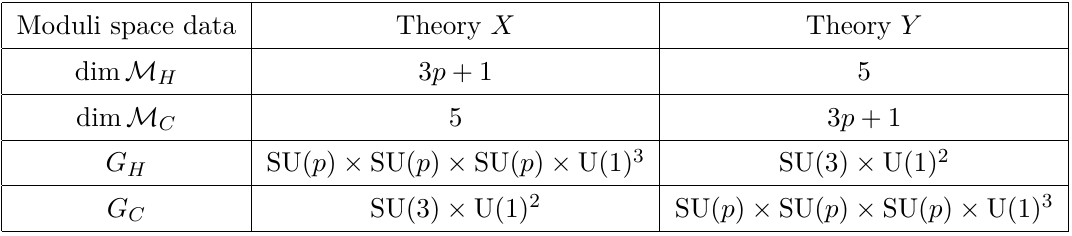
Table 14 . Summary table for the moduli space dimensions and global symmetries for the mirror pair in figure 38.